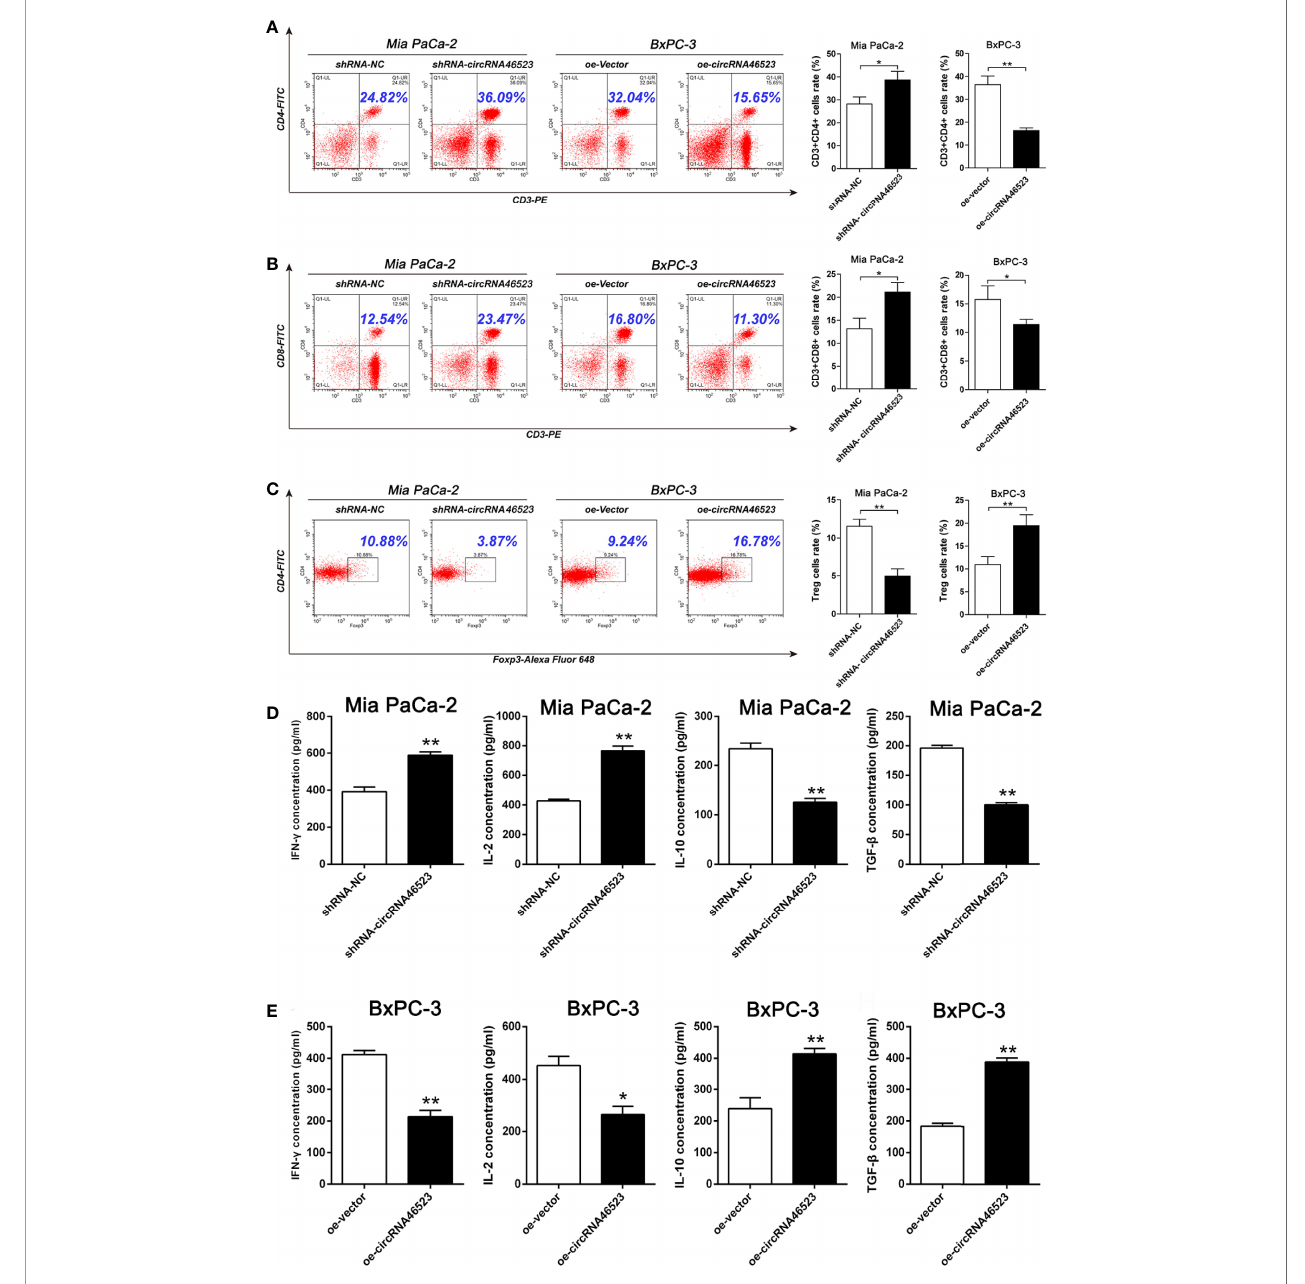
FIGURE 3 | Hsa_circ_0046523 mediated an immunosuppressive microenvironment of PC in the co-cultured system. PC cells overexpressing or knocking down hsa_circ_0046523 were co-cultured with PBMCs, (A – C) Flow cytometry analysis of the proportion of CD4 + , CD8 + T cells and Tregs in PBMCs. (D, E) ELISA analysis of the levels of the immune effect cytokines IFN- g and IL-2, and immunosuppressive cytokines IL-10 and TGF- b in the supernatant of PBMC cells. Data were expressed as means ± SD of three independent experiments. * P < 0.05, ** P <